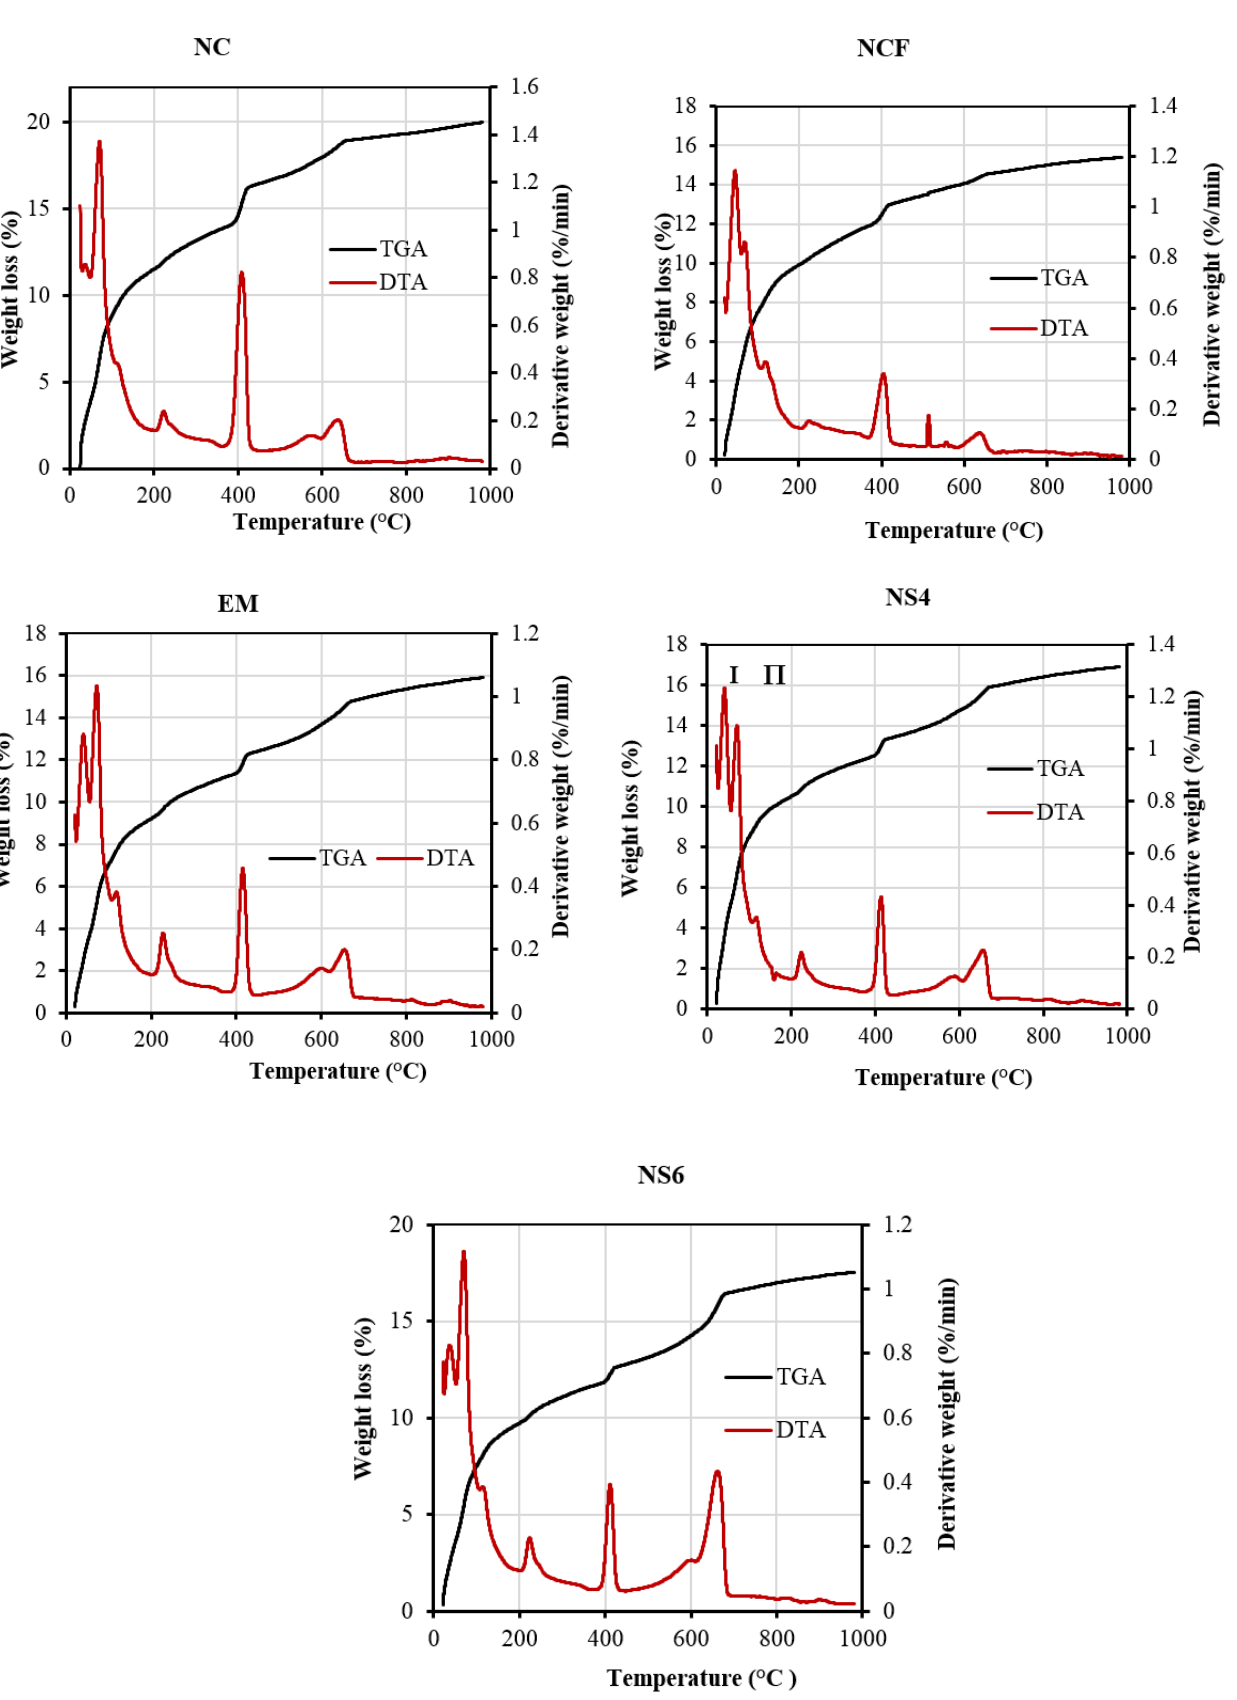
Figure 16. TGA and DTA results of the designed specimens at 28 days.